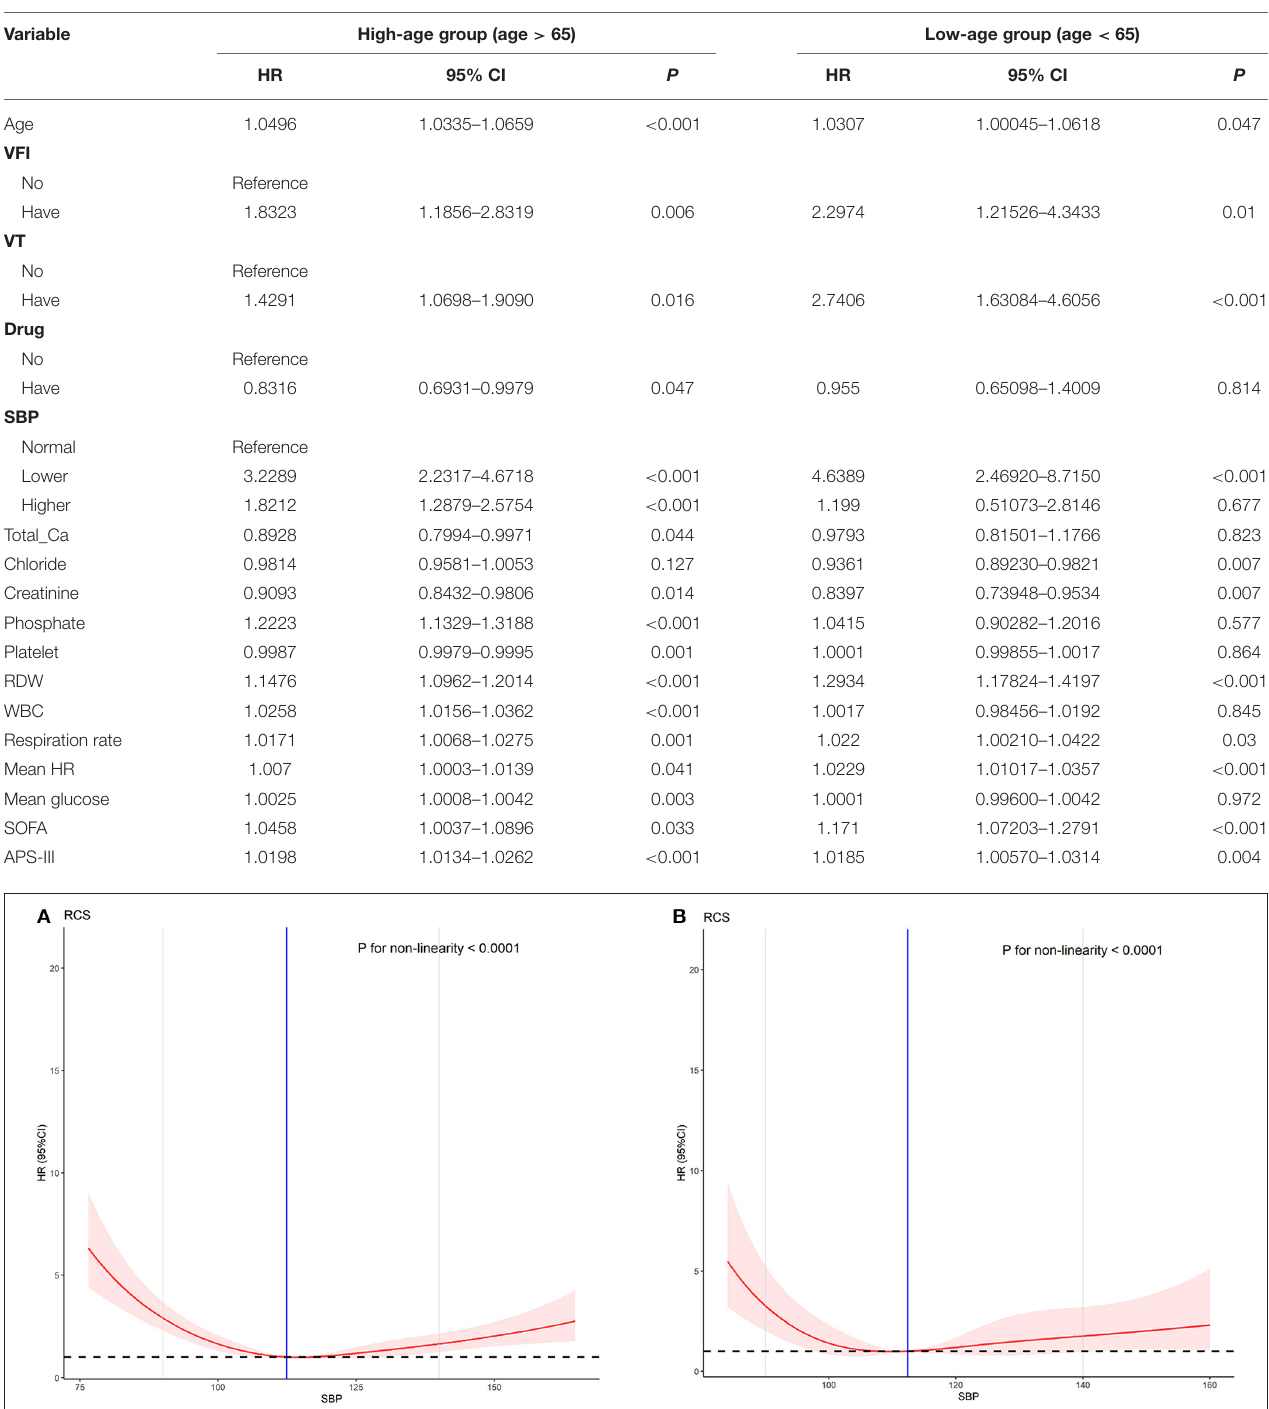
TABLE 5 | Cox regression results for different age groups.